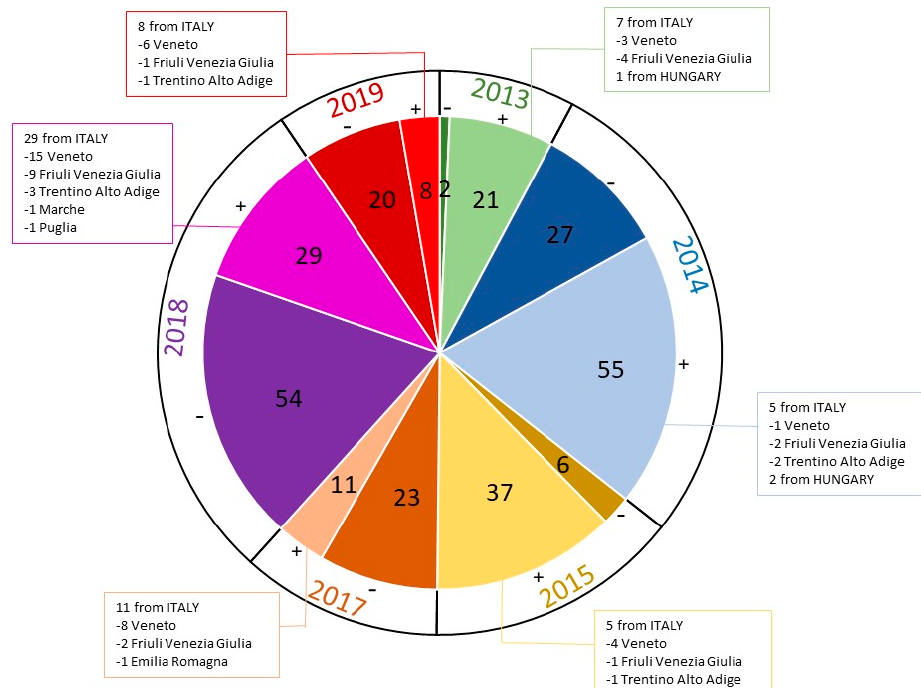
Figure 1. Pie chart of intestine samples analyzed for CPV-2 infection during 2013–2015 and 2017–2019. The pie chart reports the total number of intestine samples analyzed which were positive or negative for CPV-2 infection during 2013–2015 and 2017–2019. The lateral boxes report the state and region of origin of CPV-2-positive samples sequenced for phylogenetic analysis. Table 1. Information of CPV-2-positive samples included in the present study. Year of isolation, Italian region of origin and information regarding dog samples are reported. M = male, F = female, P =